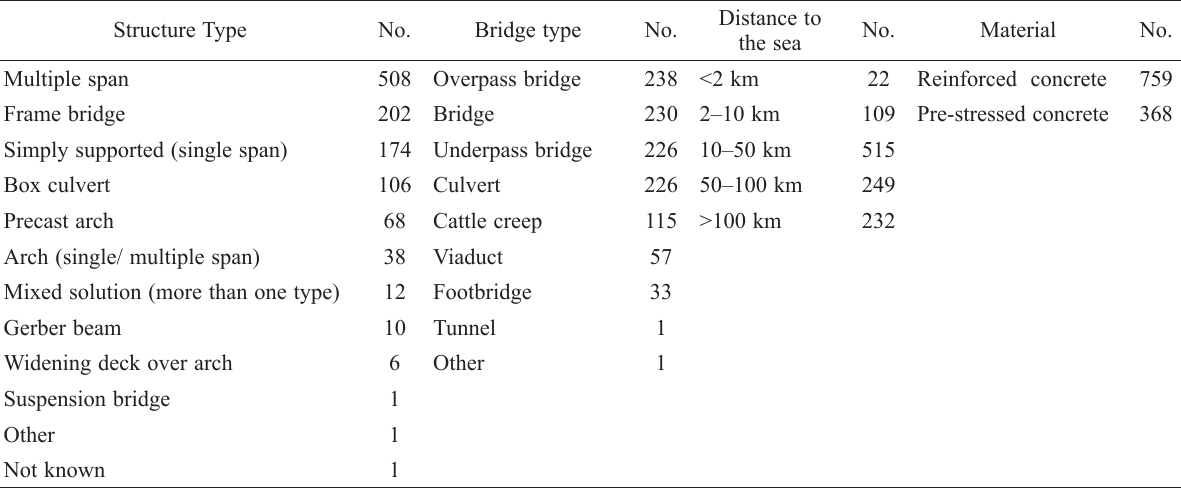
Table 2. Information for bridges regarding the structure and bridge type, distance to the sea and material, with assigned number of bridges in each